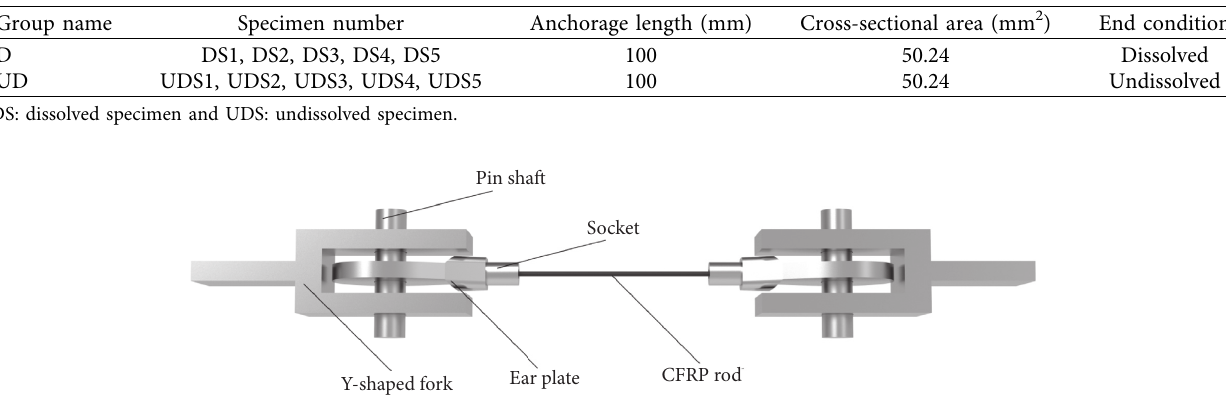
Figure 12: Photo of the specimen. Table 1: Two groups of specimens.